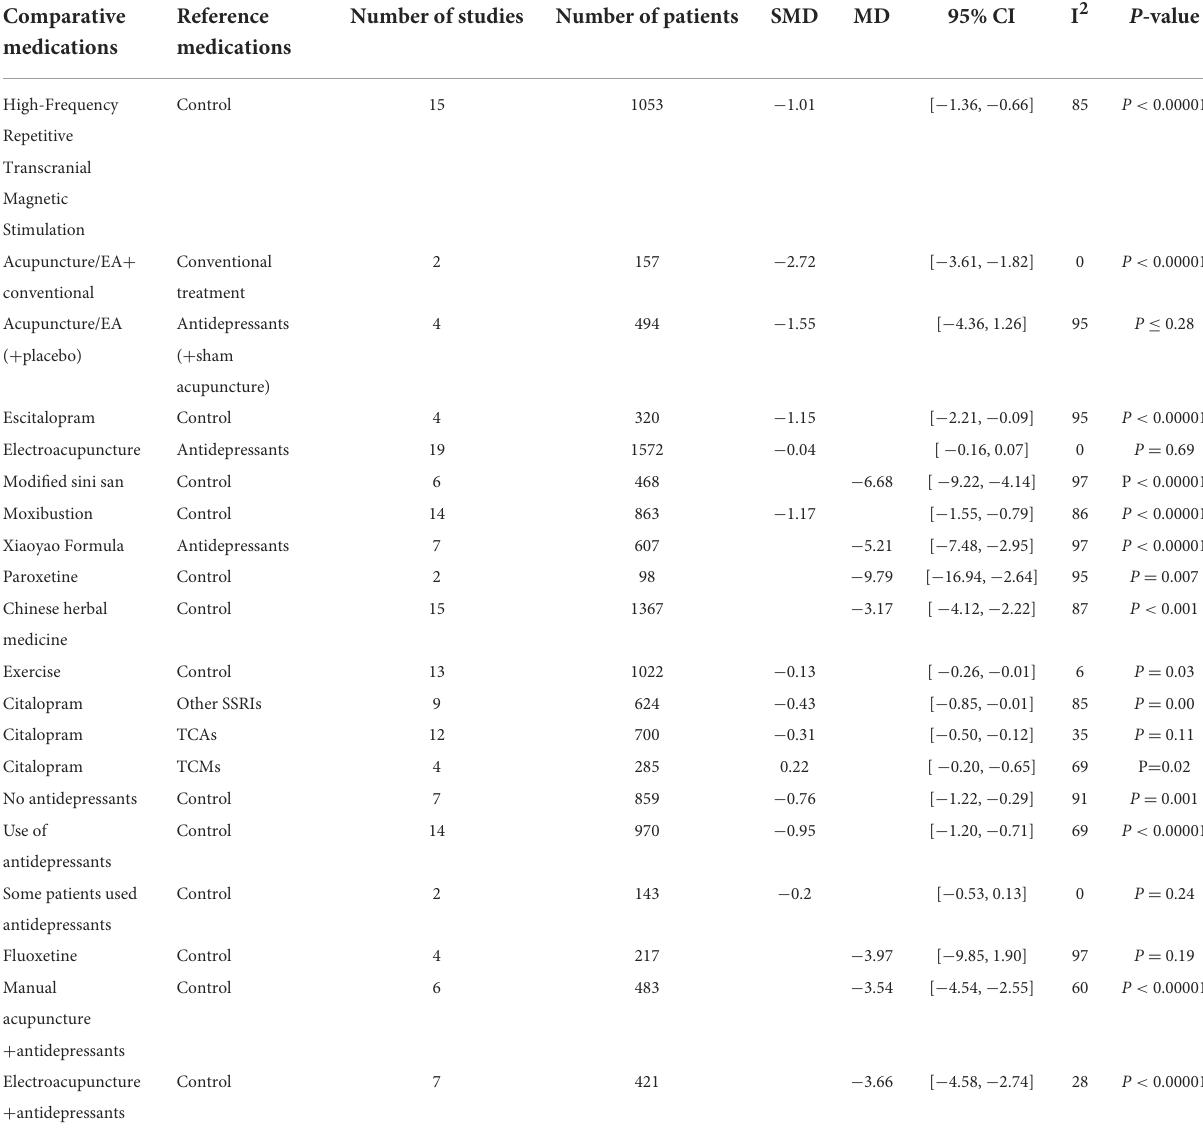
Pairwise meta-analyses